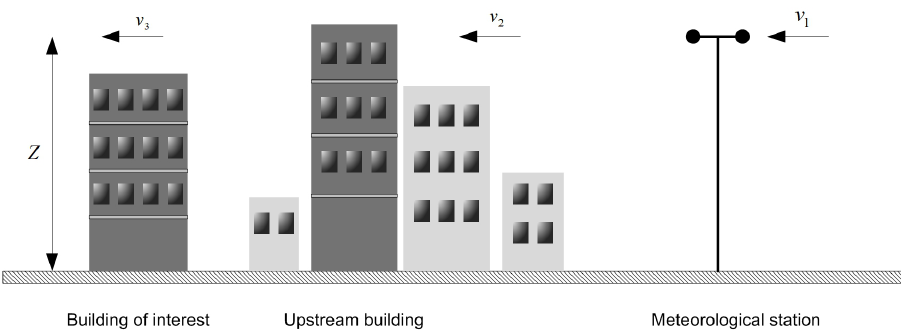
Figure 2. Determination of the velocity v 3 at the building of interest (shaded) using meteorological information. Wind tunnel tests on the same urban zone would be carried out in order to find the ratio v 3 . Figure adapted and simplified from Al-Quraan et al. v 2